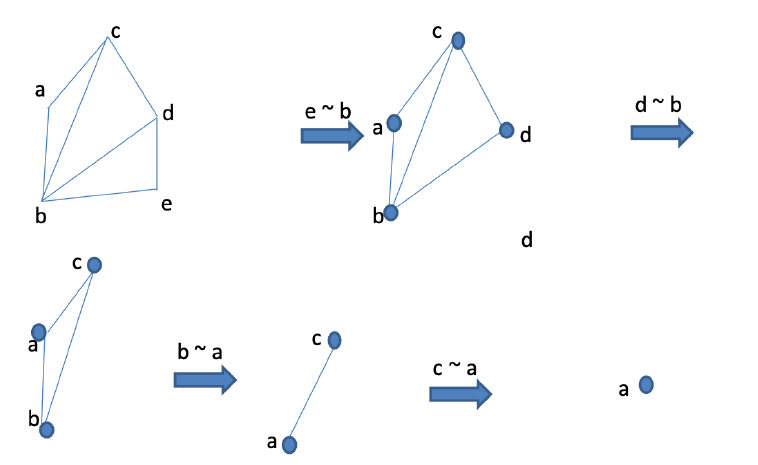
Figure 2. An example of a dismantlable graph.